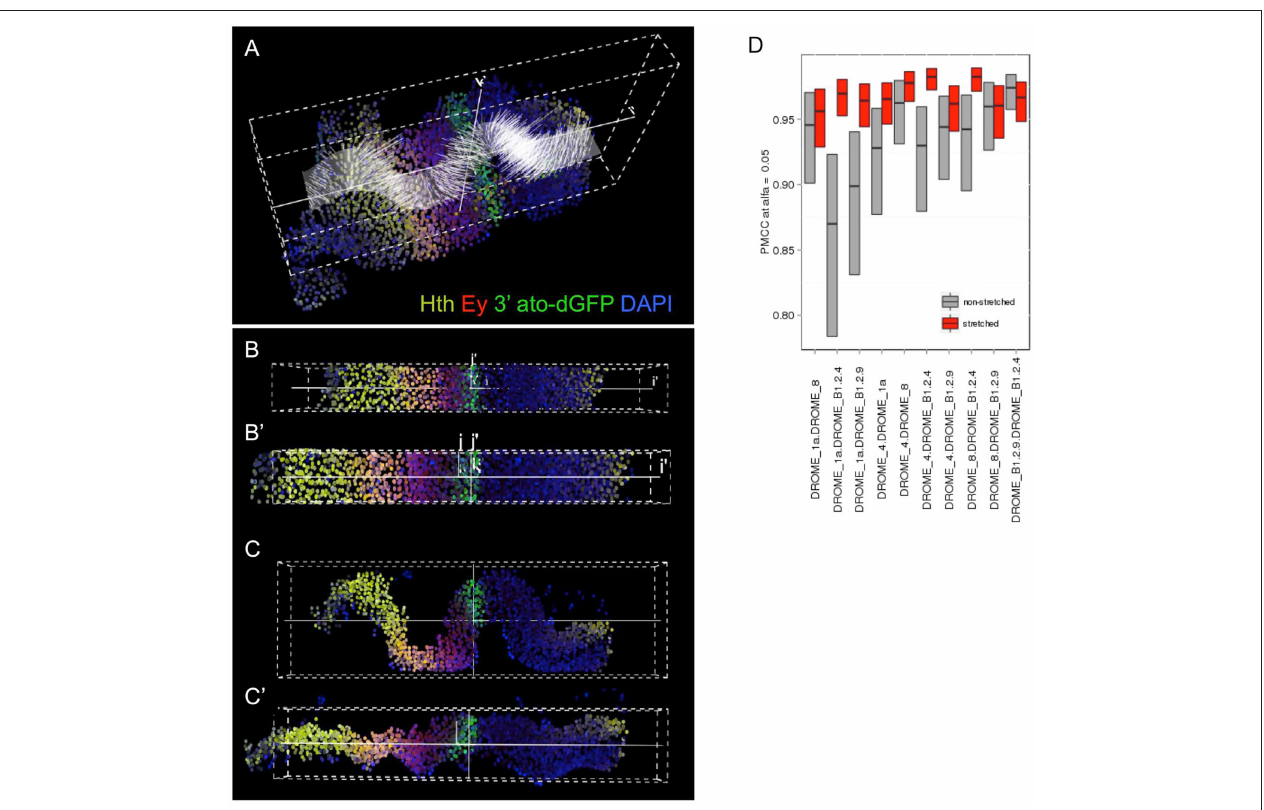
FIGURE 2 | Computer-aided stretching of the tissue improves the registration of gene expression profiles. The folding of the disc epithelium is an important source of analytical error. We have developed an iFLIC plug-in (see Supplementary Material ) that solves sufficiently this problem by estimating the actual z coordinate for each nucleus centroid of the sampled tissue and calculates the orthogonal projection of each cell on that surface (A) . The disc shown is from an ato-dGFP individual, stained for GFP (ato), Hth (yellow), Ey (red), and DAPI (blue). The results of the computer-aided stretching are shown in ( B,B ′ : top views) and ( C,C ′ : lateral views). B ′ and C ′ are the stretched data. (D) Comparison of the Pearson’s correlation coefficient (PMCC) of gene profiles in several independent samples by combining them in pairs, either non-stretched (gray) or after stretching (red) (D) . Stretching leads to a general improvement of the PMCC. PMCC was computed by Fisher’s transform, showing confidence intervals at α =